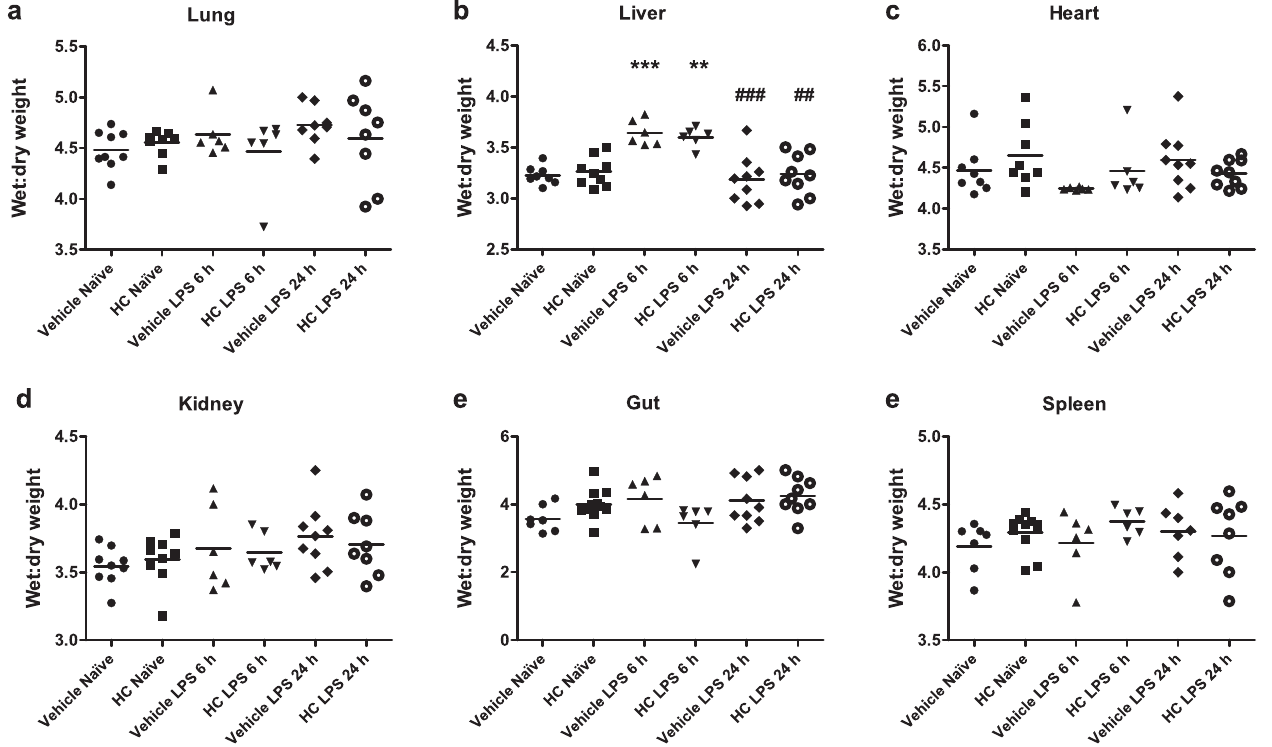
Figure 7. Oedema formation in WT mice treated with TRPV4 antagonist or vehicle. Oedema formation was measured by comparing wet and dry weights of ( a ) lungs, ( b ) upper liver lobes, ( c ) hearts, ( d ) right kidneys, ( e ) 1-cm sections of small intestine and ( f ) whole spleens. WT mice were treated i.p. with vehicle (10% DMSO) or HC-067047 (HC) at the time of LPS (12.5 mg/kg, i.v., 6 or 24 h). Values for each animal are presented as individual symbols, with horizontal line denoting group mean. **p<0.01, ***p<0.001, relative to naïve controls, 1-way ANOVA + Bonferroni post-hoc test (n =